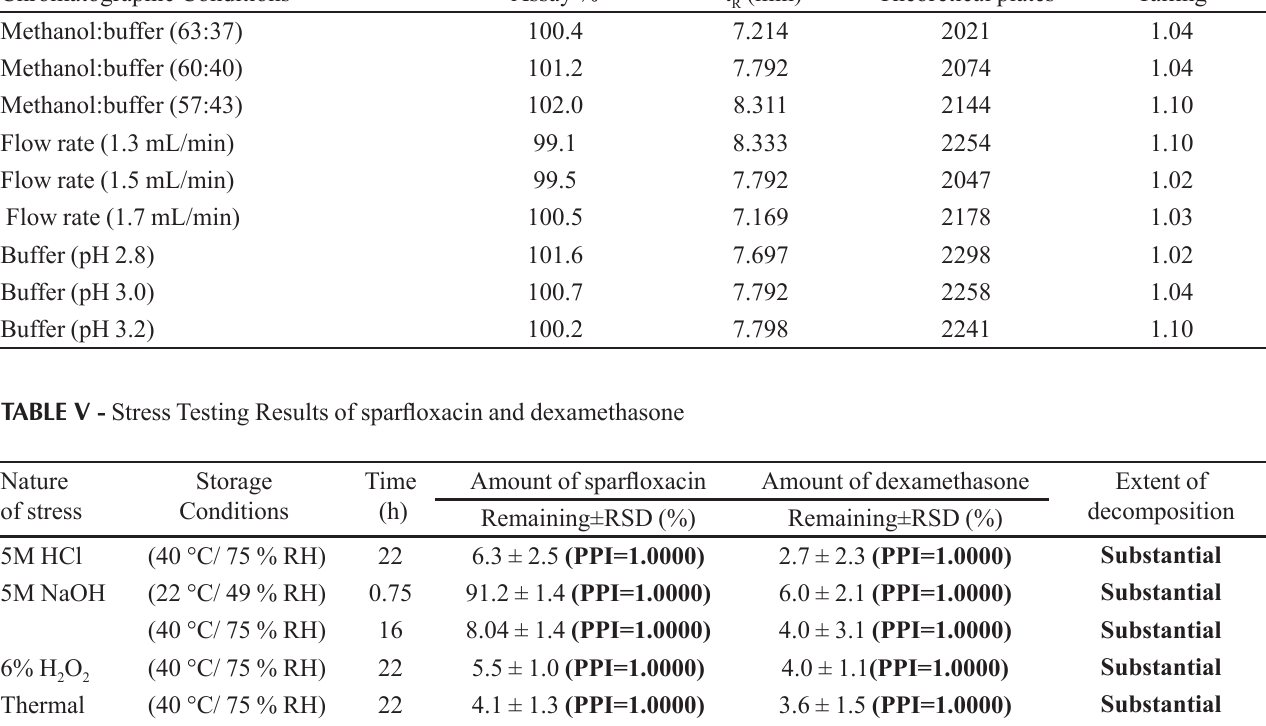
TABLE IV - Robustness study of dexamethasone Chromatographic Conditions